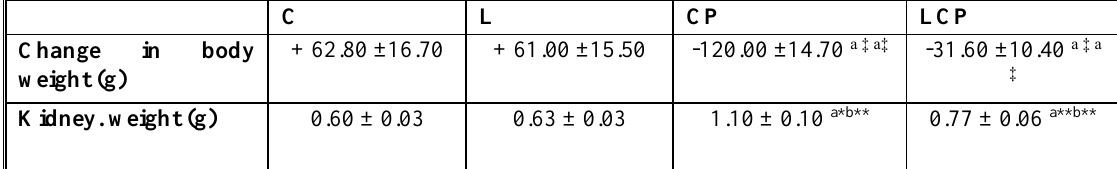
Table 1. The changes in body weights and kidney weights in different groups of